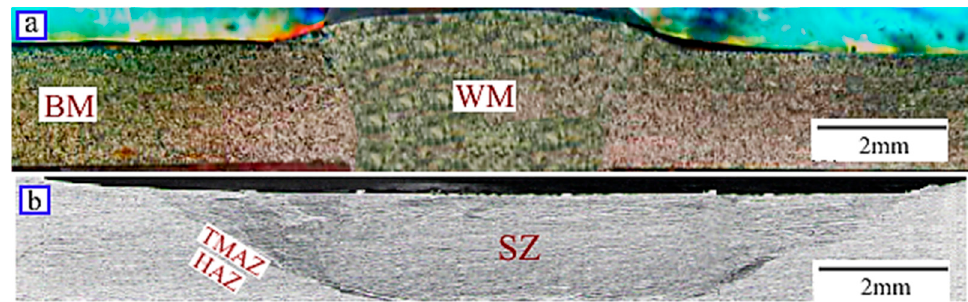
Figure 3. Optical micrographs showing the cross-section of the ( a ) unprocessed and ( b ) friction-stir-processed weldment.